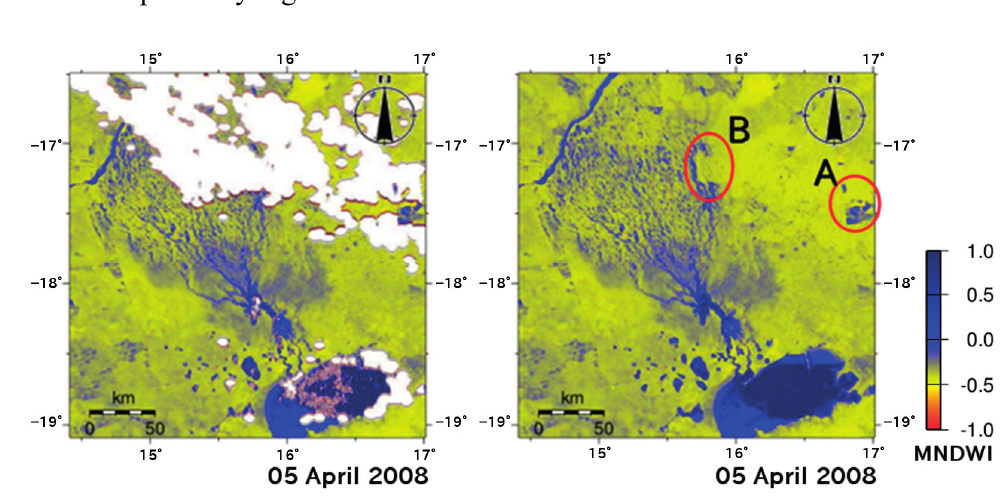
Figure 8. The result of gap-filling using the database unmixing method. The left figure is the map before gap-filling and the right is the map after gap-filling. The red circles represent an implausibly high MNDWI at site A and a too-low MNDWI at site B.